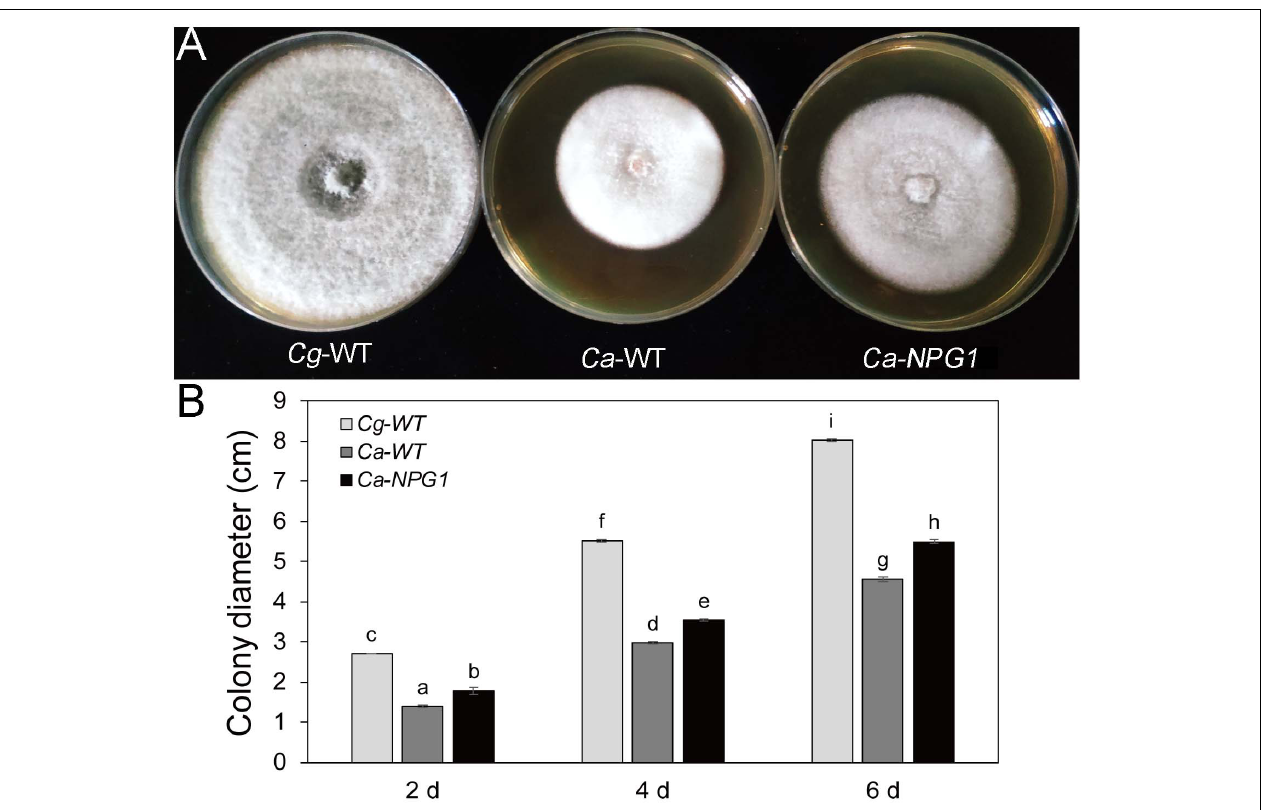
FIGURE 4 | Growth rate assays of C. acutatum Hb strains expressing CgNPG1 . (A) Colonial morphology of C. gloeosporioides Hb wild type strain (Cg-WT), C. acutatum Hb wild type strain (Ca-WT), and the CgNPG1 heterologous expression mutant (Ca- NPG1 ). (B) Colony diameters at 2, 4, and 6 day post-inoculation. Error bars indicated standard deviation, and columns with different letters indicate significant difference ( P <